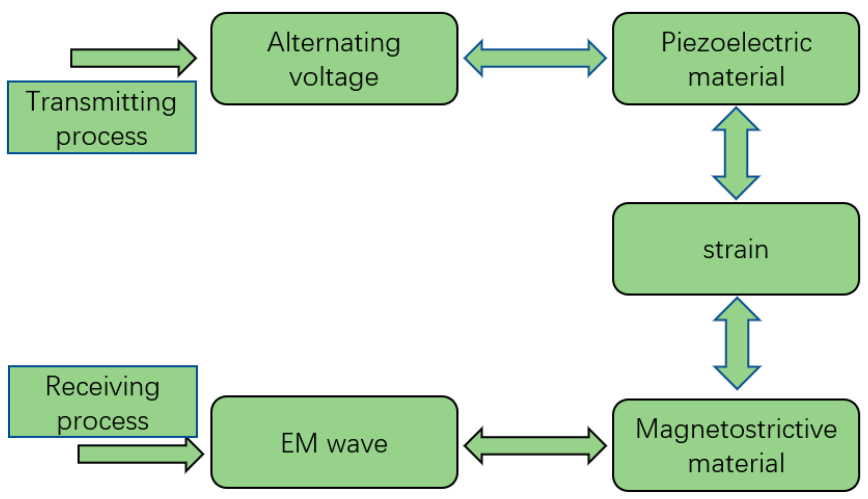
Figure 1. The working principle of the ME antenna.